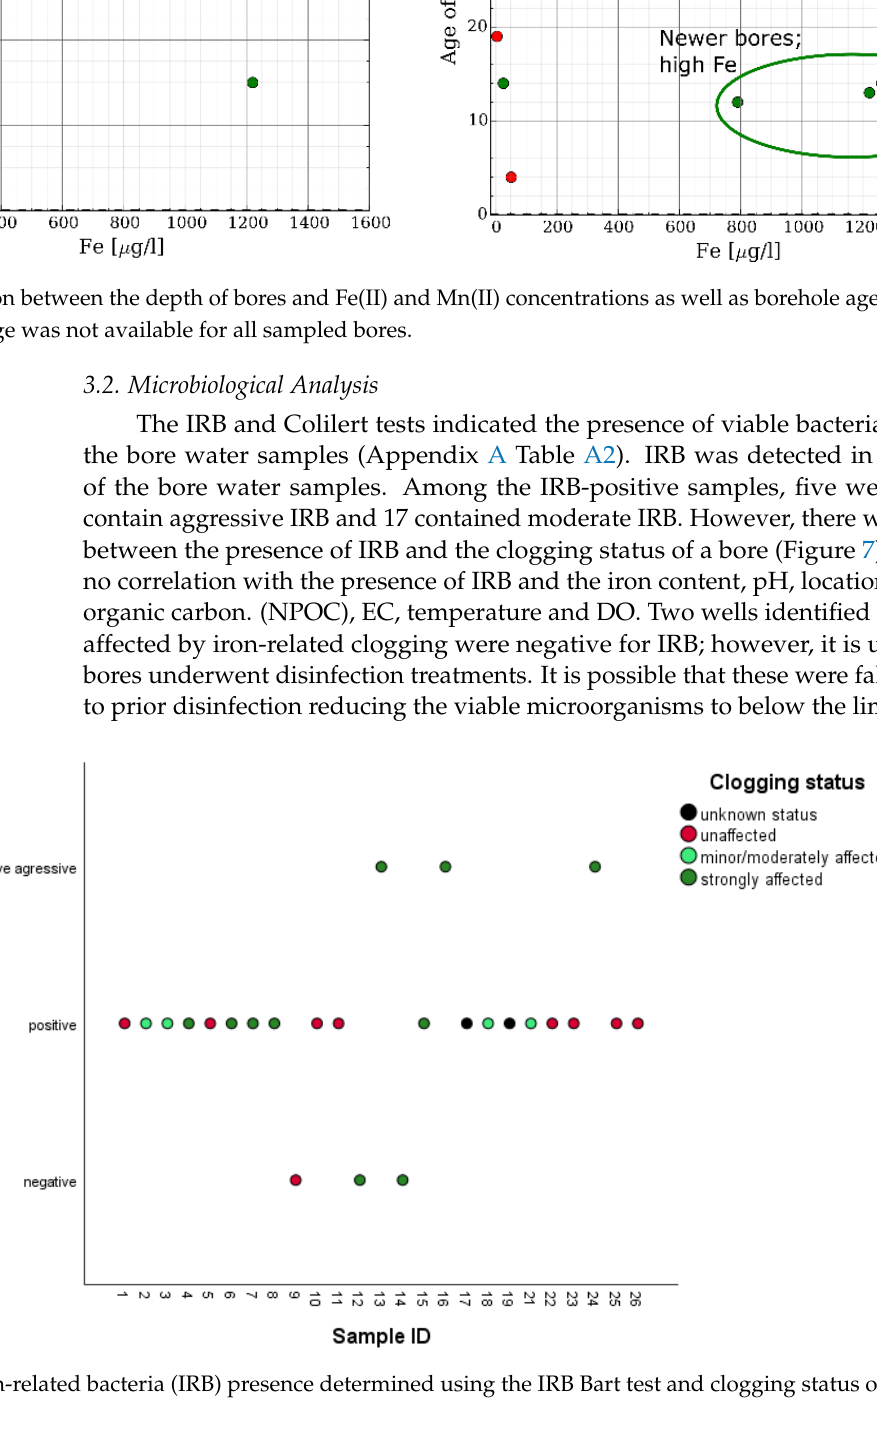
Figure 7. Iron-related bacteria (IRB) presence determined using the IRB Bart test and clogging status of bores.